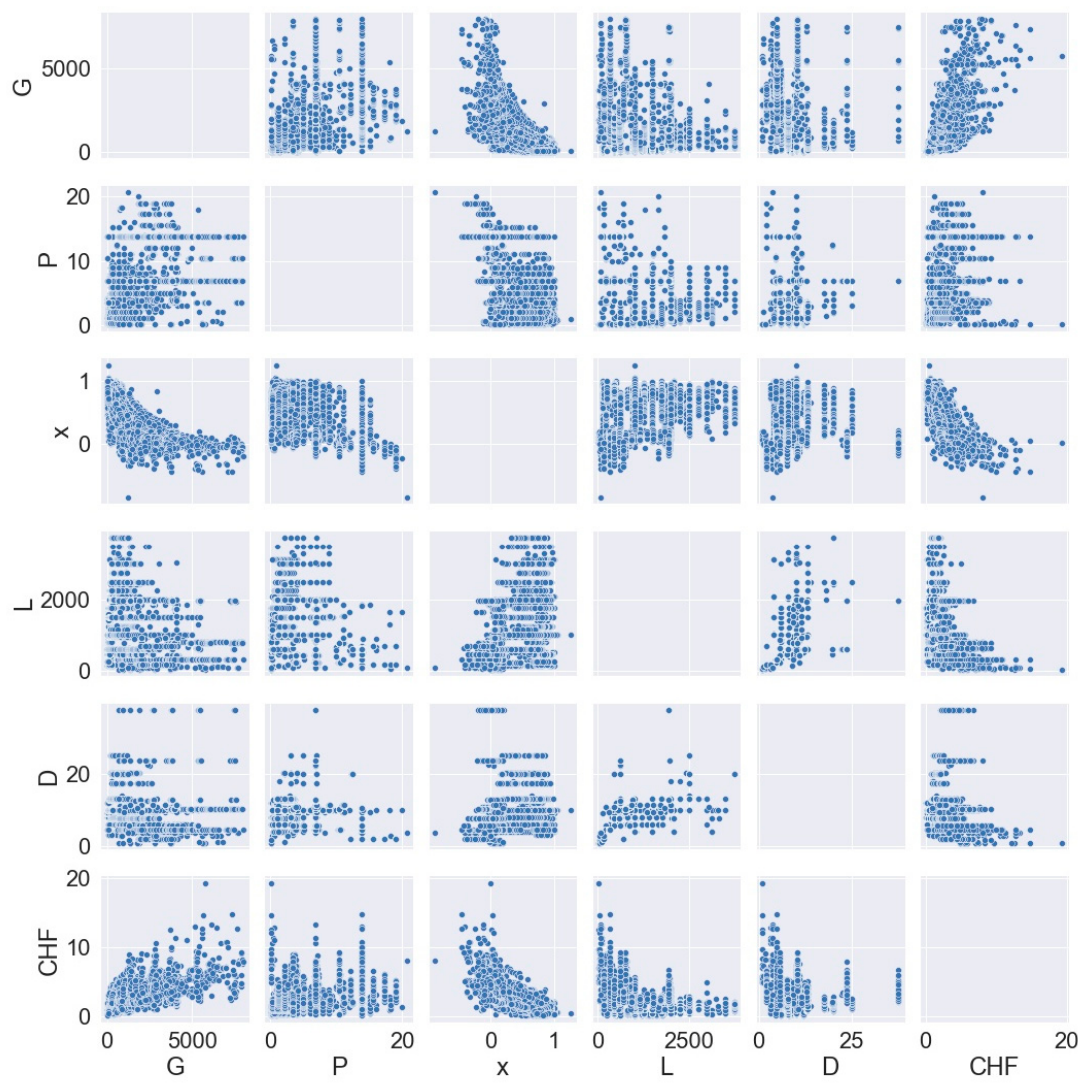
Figure 1. Distribution of CHF dataset as function of two variables.